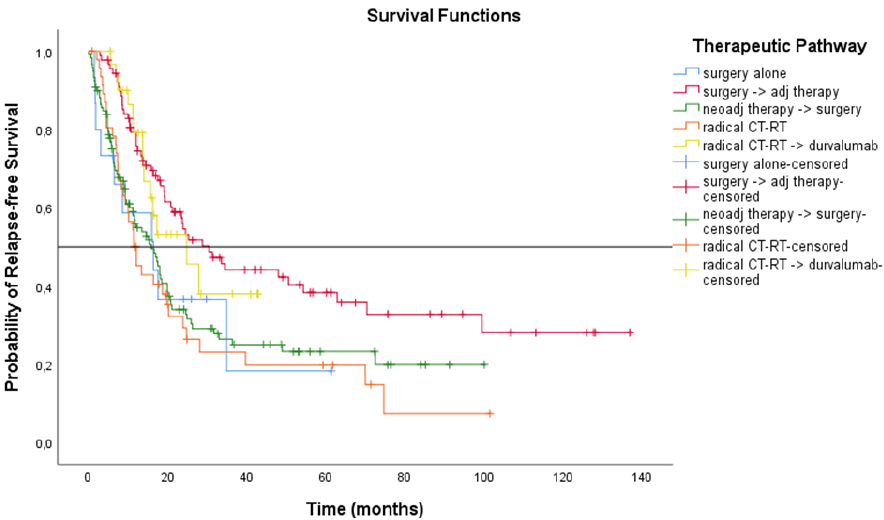
Figure 6. Kaplan–Meier curves of estimated relapse-free survival in the intention-to-treat population as per radical treatment modality. CT-RT, chemo-radiation therapy.